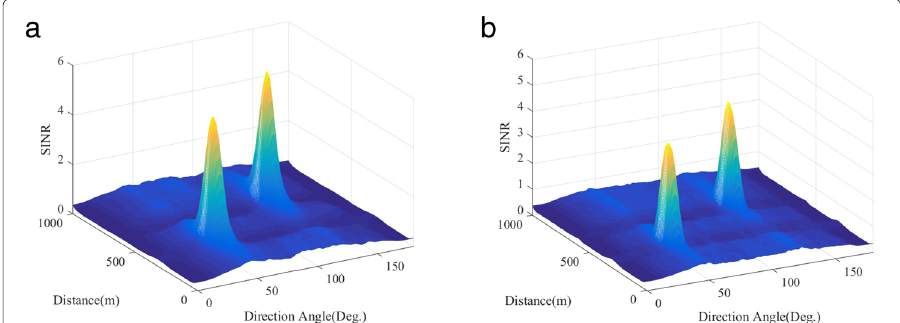
Fig. 3 The 3D surface of SINR versus the direction angle and the distance of the proposed